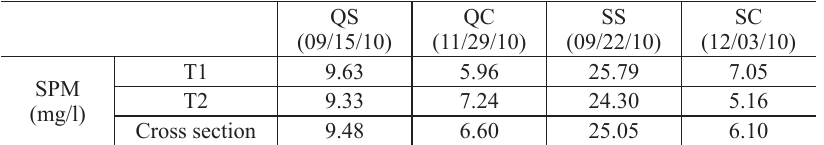
Mean values for the points T1, T2 and the channel cross section. SPM - concentration of suspended particulate